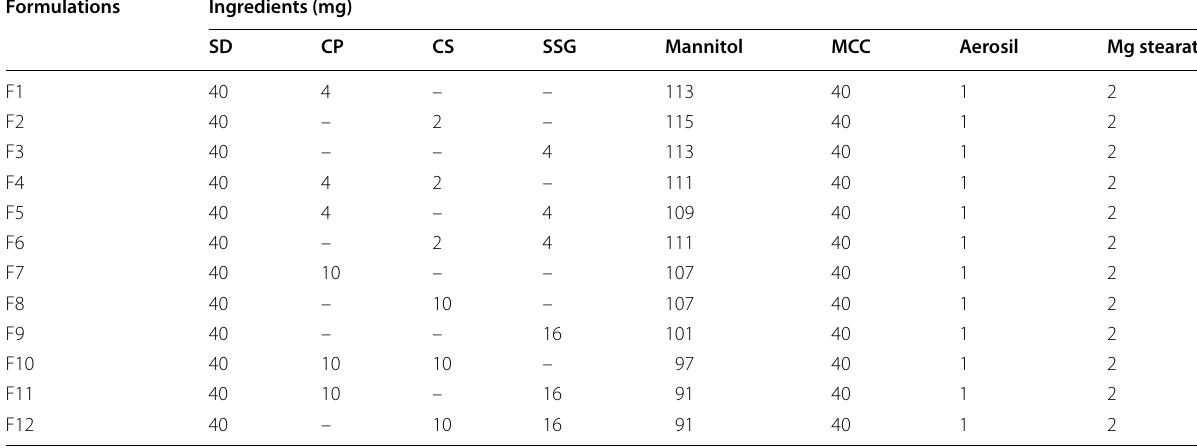
SD Solid dispersion, CP Crospovidone, CS Croscarmellose, SSG Sodium starch glycolate, MCC Microcrystalline cellulose, Mg stearate Magnesium stearate